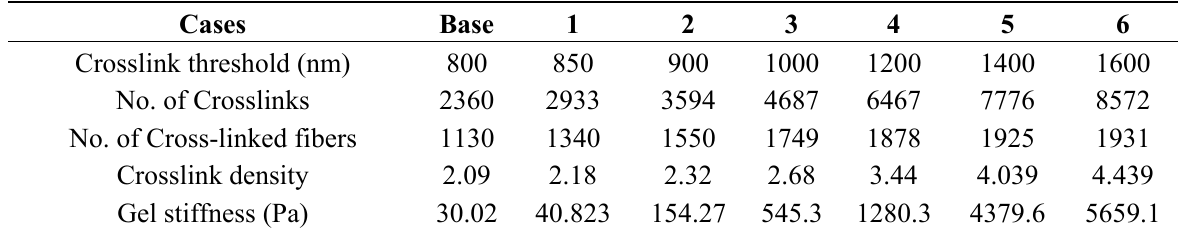
Table 1. RVE models with different crosslink